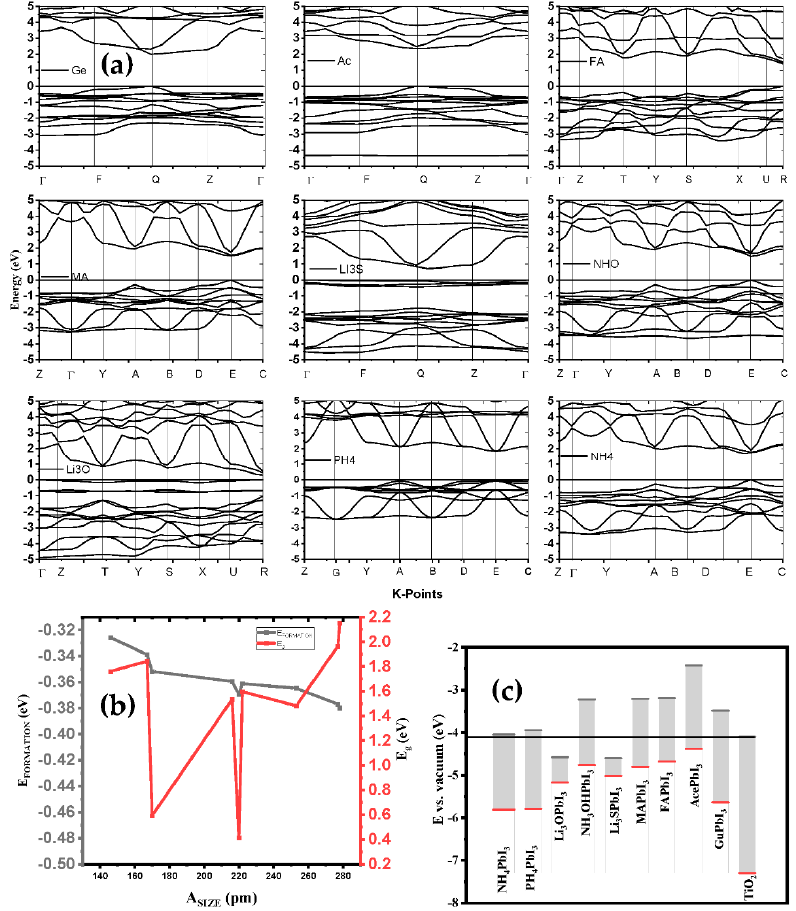
Figure 7. ( a ) The variation of formation energy and bandgap function of the different cations; ( b ) the potential energy with A i PbI 3 ; and ( c ) band structure of A i PbI 3 in comparison with Van der Waals. 2.7.